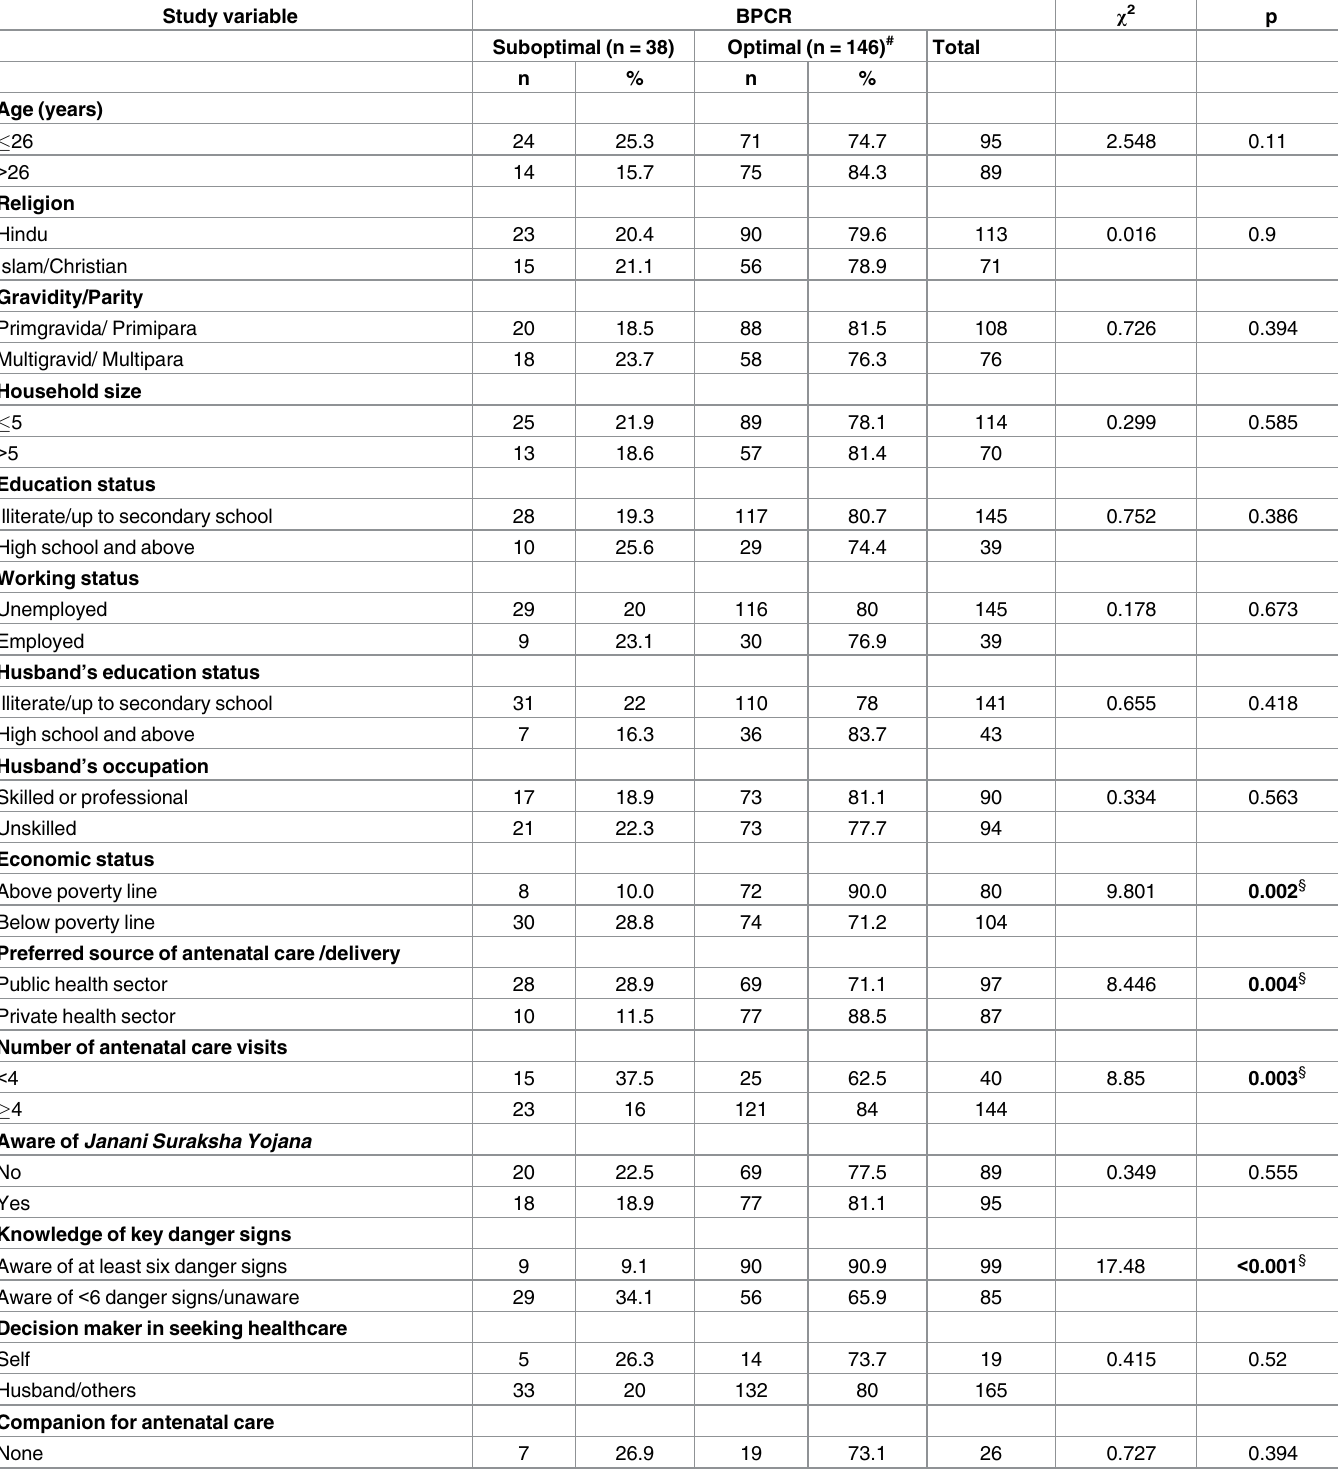
Table 2. Association between birth preparedness and complication readiness (BPCR), and socio-demographic and obstetric parameters of women attending two rural primary health centers, Dakshina Kannada district, Karnataka, India, June-September 2013 (n = 184). Study